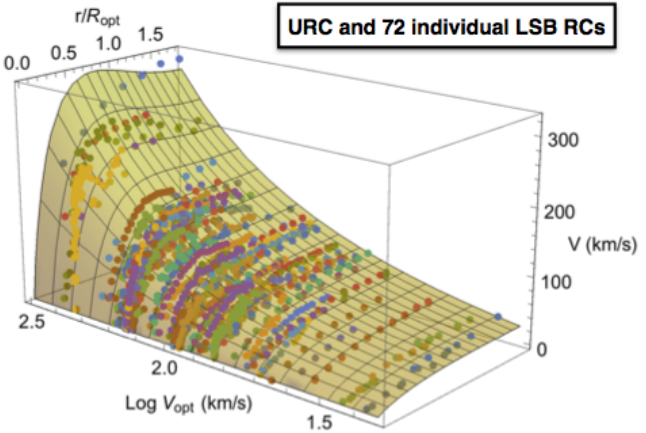
Figure 18. URC-LSB (Equations (21) and (22) in [38]), with compactness Log C (cid:63) = 0 and the individ- ual 72 LSBs rotation curves. Image reproduced from